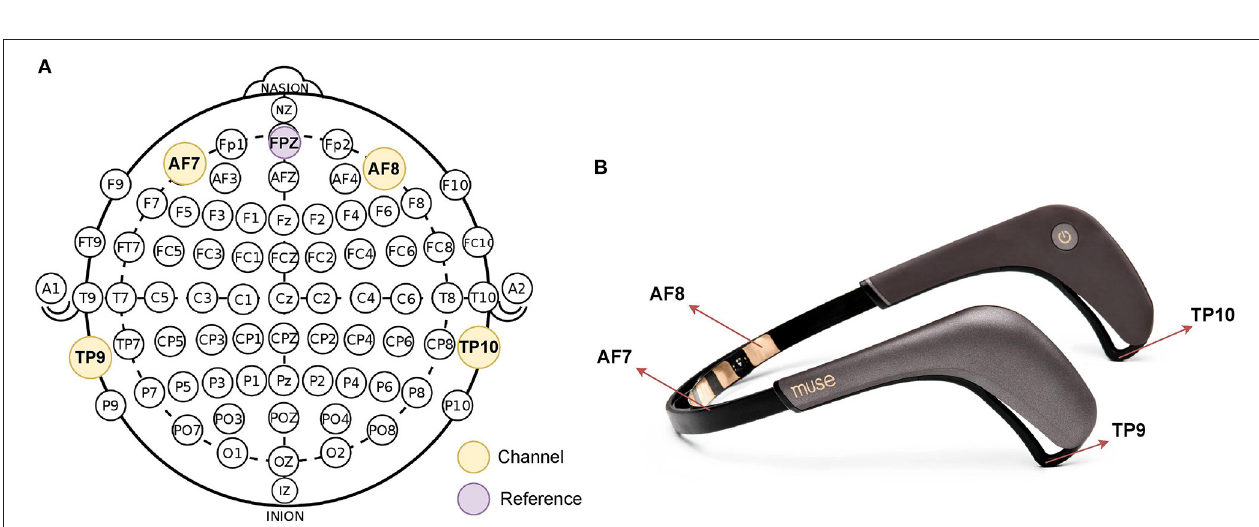
FIGURE 1 | (A) Task 1 (simple sliding finger along the same direction); a white dot of 5 mm diameter appears on screen followed by a solid green 8 mm diameter circle in the center of the screen; the user has to then slide the solid green dot to an open green peripheral target. (B) Task 2, A CMI task: A vertical white line (shown as dark gray in the image) divides the screen in to two halves; a white dot of 5 mm diameter appears on the right half of the screen followed by a solid green on the left side of the screen; the user has to then slide the solid green dot to an open green peripheral target by sliding the finger in the opposite direction of the open green target on the right side of the